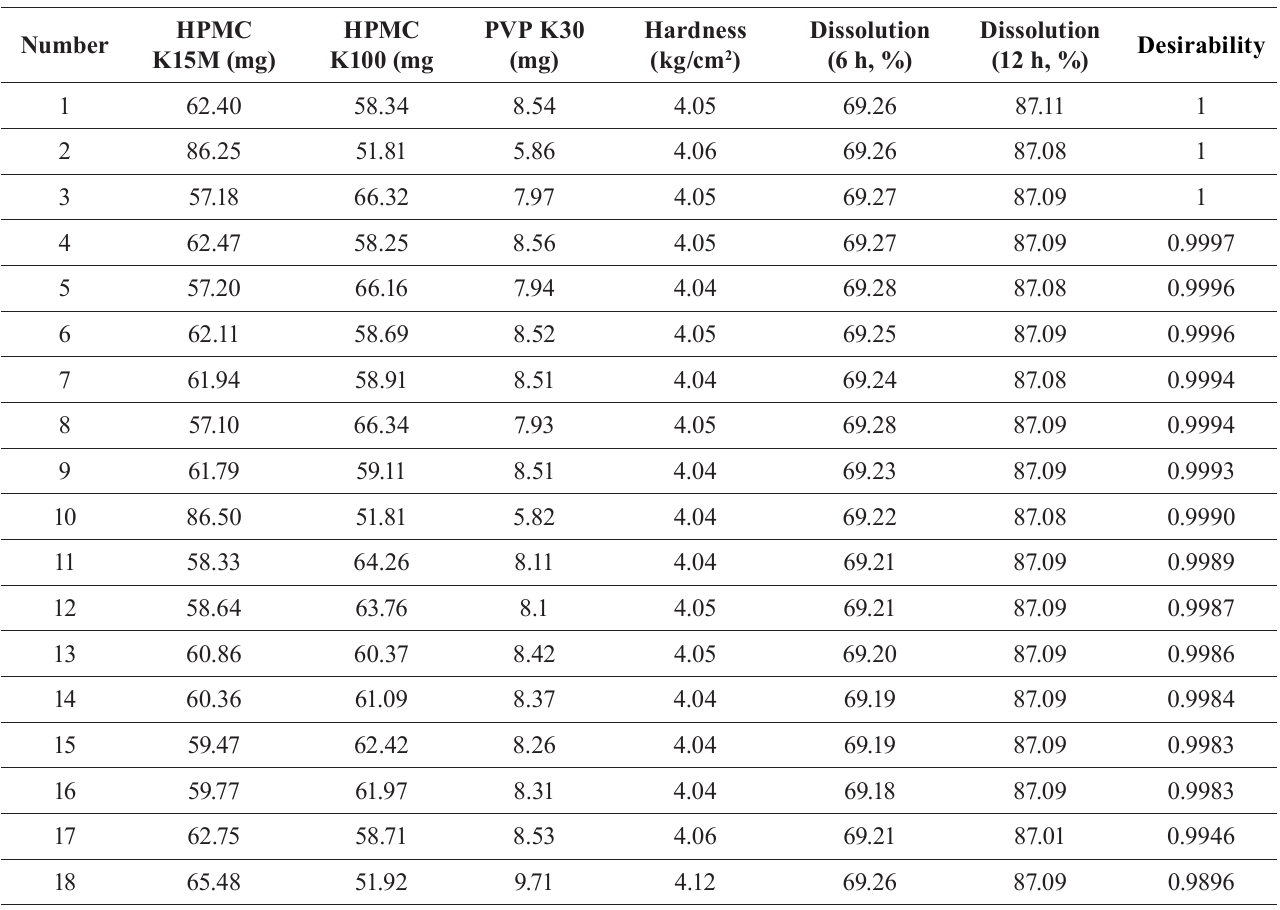
TABLE VI - Results of desirability function analysis